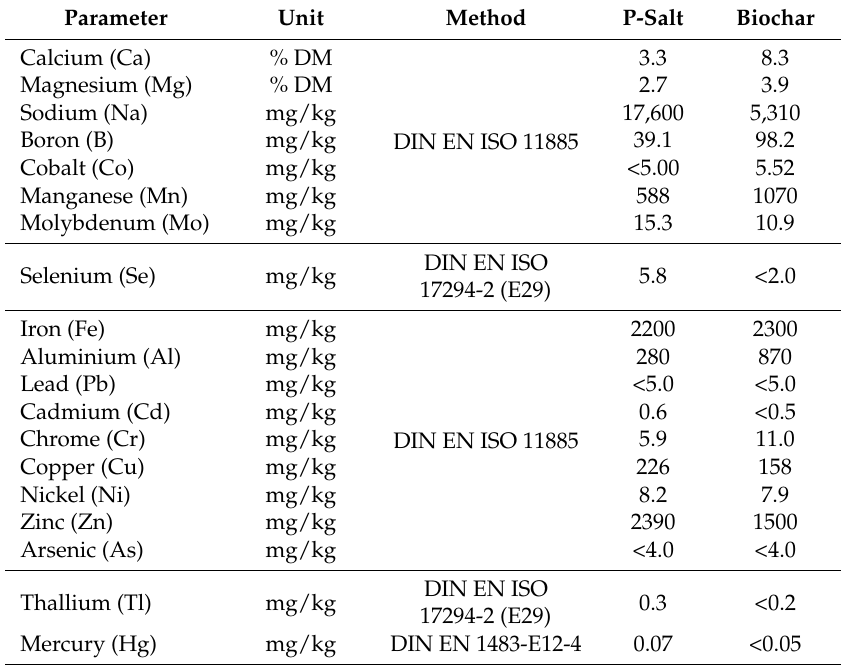
Table A1. List of additionally analysed parameters measured in phosphate salts (P-Salt) and biochar and methods